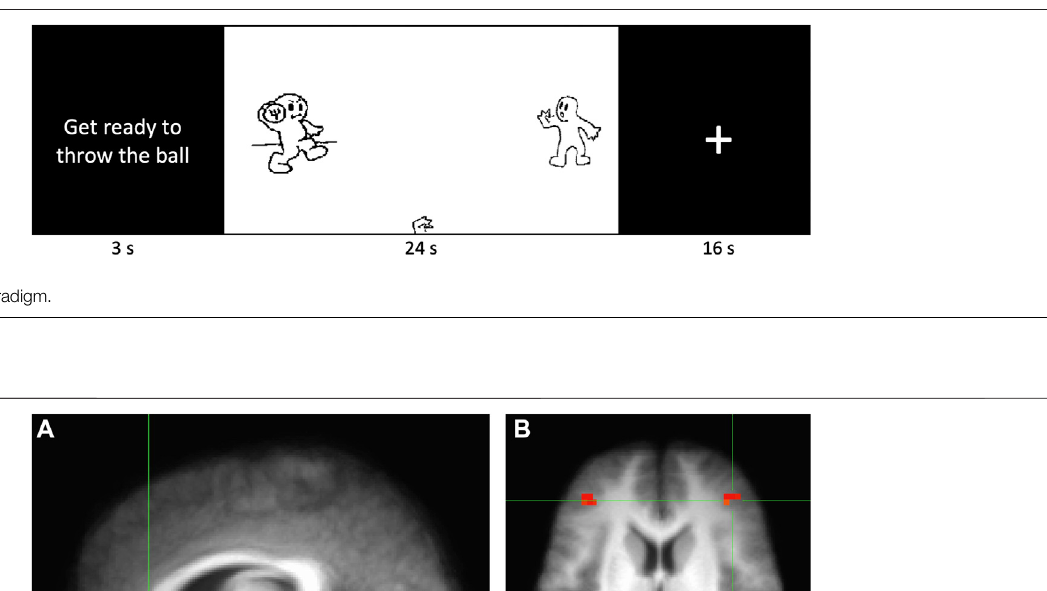
Frontiers in Sociology |